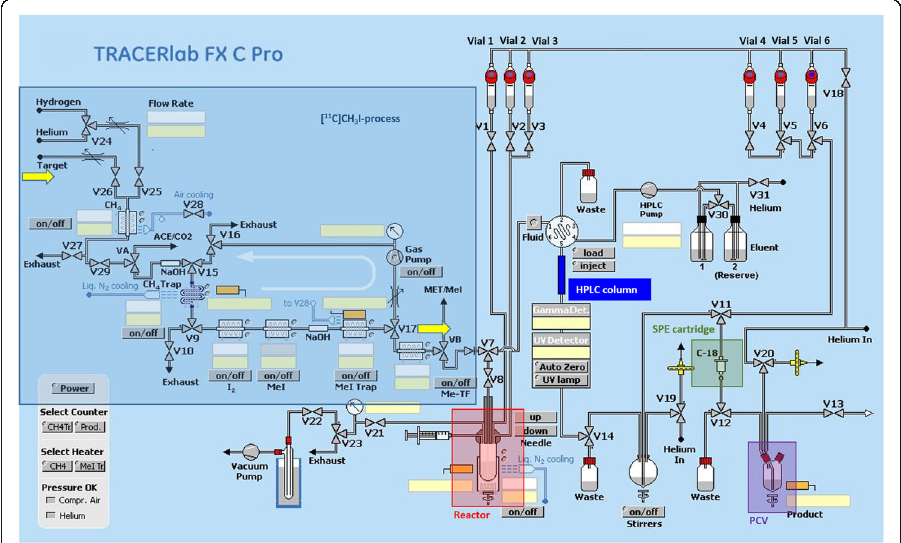
Fig. 1 Scheme of the commercial 11 C-synthesizer used for the radiosynthesis and purification of [ 11 C]erlotinib (SPE: solid phase extraction; PCV: product collection